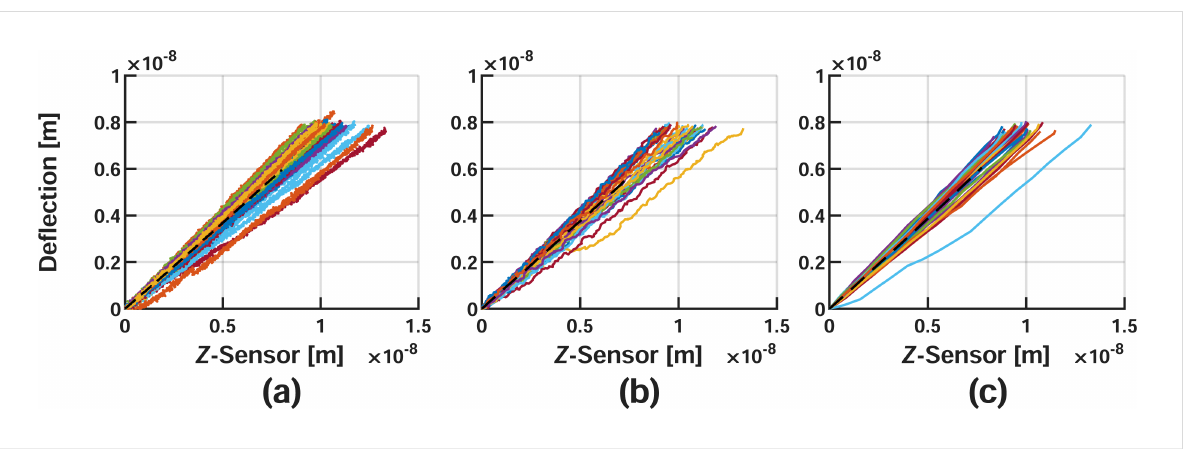
Figure 5: Repulsive (i.e., force application) portion of the curves in Figure 4 extracted for fitting. Corrected nylon data for (a) 10 nm/s, (b) 100 nm/s, and (c) 1000 nm/s. The colored lines represent various datasets included during the averaging process, and the dashed black lines show the aver- aged repulsive result. As the approach velocity decreases, the slope of each averaged dataset will also tend to decrease, meaning that less deflec- tion occurs for a given Z -sensor reading. This is intuitive, as the material is given additional time to yield for slower approach velocities, thus appearing